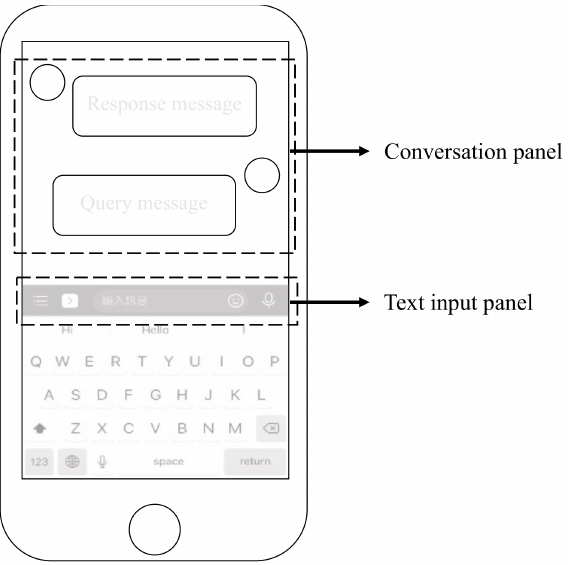
Figure 7. The developed method allows the user to input natural language through the text input